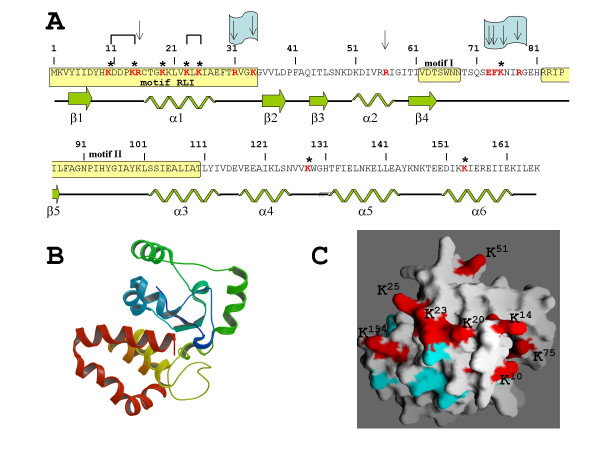
Experimental topology information obtained on SSO0551 and theoretical 3D model M8 shown to be compatible. A – Schematic representation of experimental low-resolution structural information. SSO0551 sequence is displayed with its predicted secondary structural elements (α-helices and β-strands are represented by helices and arrows, respectively). The two conserved COG2042 motifs described in this study (I and II) and the 35 amino acids RLI motif are specified. Vertical arrows indicate sites of limited proteolysis that have been experimentally determined. Lysines labeled with NHS-biotin are indicated with asterisks and lysines involved in DTSSP cross-links are schematically bridged. Sequence numbering refers to the native version (untagged) of SSO0551 experimentally characterized. B – Schematic drawing of ab initio model M8. Secondary structure elements are shown as coil for α-helices, arrows for β-strands, and lines for loops. The color code follows a rainbow style where N terminus is in blue and C terminus in red. C – Molecular surface of ab initio model M8. The localization of solvent-exposed lysines, as determined by NHS-biotin labeling experiments, is colored in red whereas other lysines are colored in blue. This view shows the protein in the same orientation as in B.